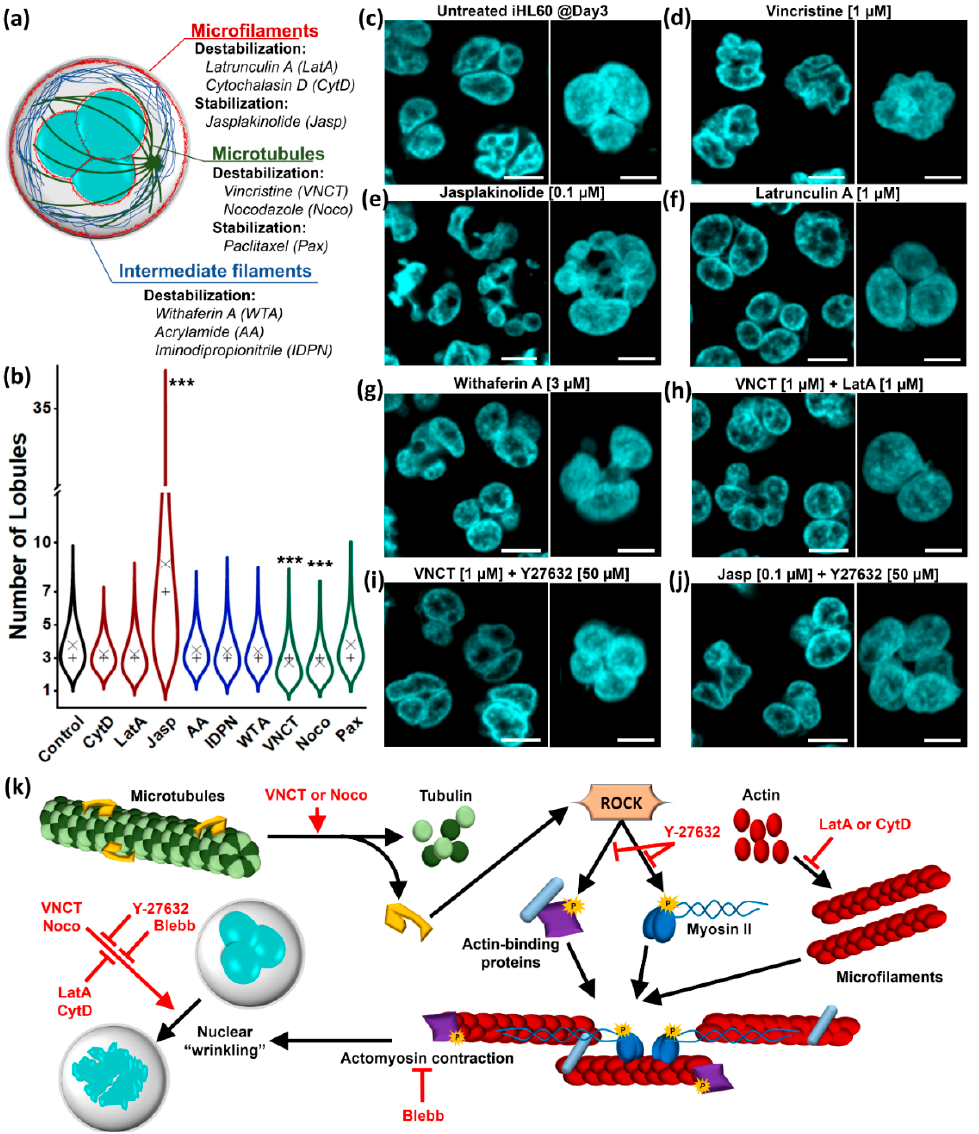
Figure 1. Effect of cytoskeleton on lobular structure maintenance. ( a ) Schematic representation of cytosolic cytoskeleton networks and component-specific small molecules (presented with effect on target component and employed drug abbreviation). ( b ) Quantification of lobule number in live-cell DNA staining in Day3 iHL60 (minimum sample number = 100; × = mean; + = median; *** = p < 0.001, Kruskal–Wallis test with Dunn post-hoc comparison). ( c – j ) Representative pictures of live-cell nuclear staining in Day 3 iHL60 treated for 3 h with the reported small molecule or combination of molecules (mid-focal section scale bar = 10 μ m; 3D reconstruction inset scale bar = 5 μ m). ( k ) Schematic representation of the complex interactions between MTs and MFs relative to the nuclear “wrinkling” effect, highlighting how cytosolic cytoskeletal components can be specifically, but not independently, targeted.